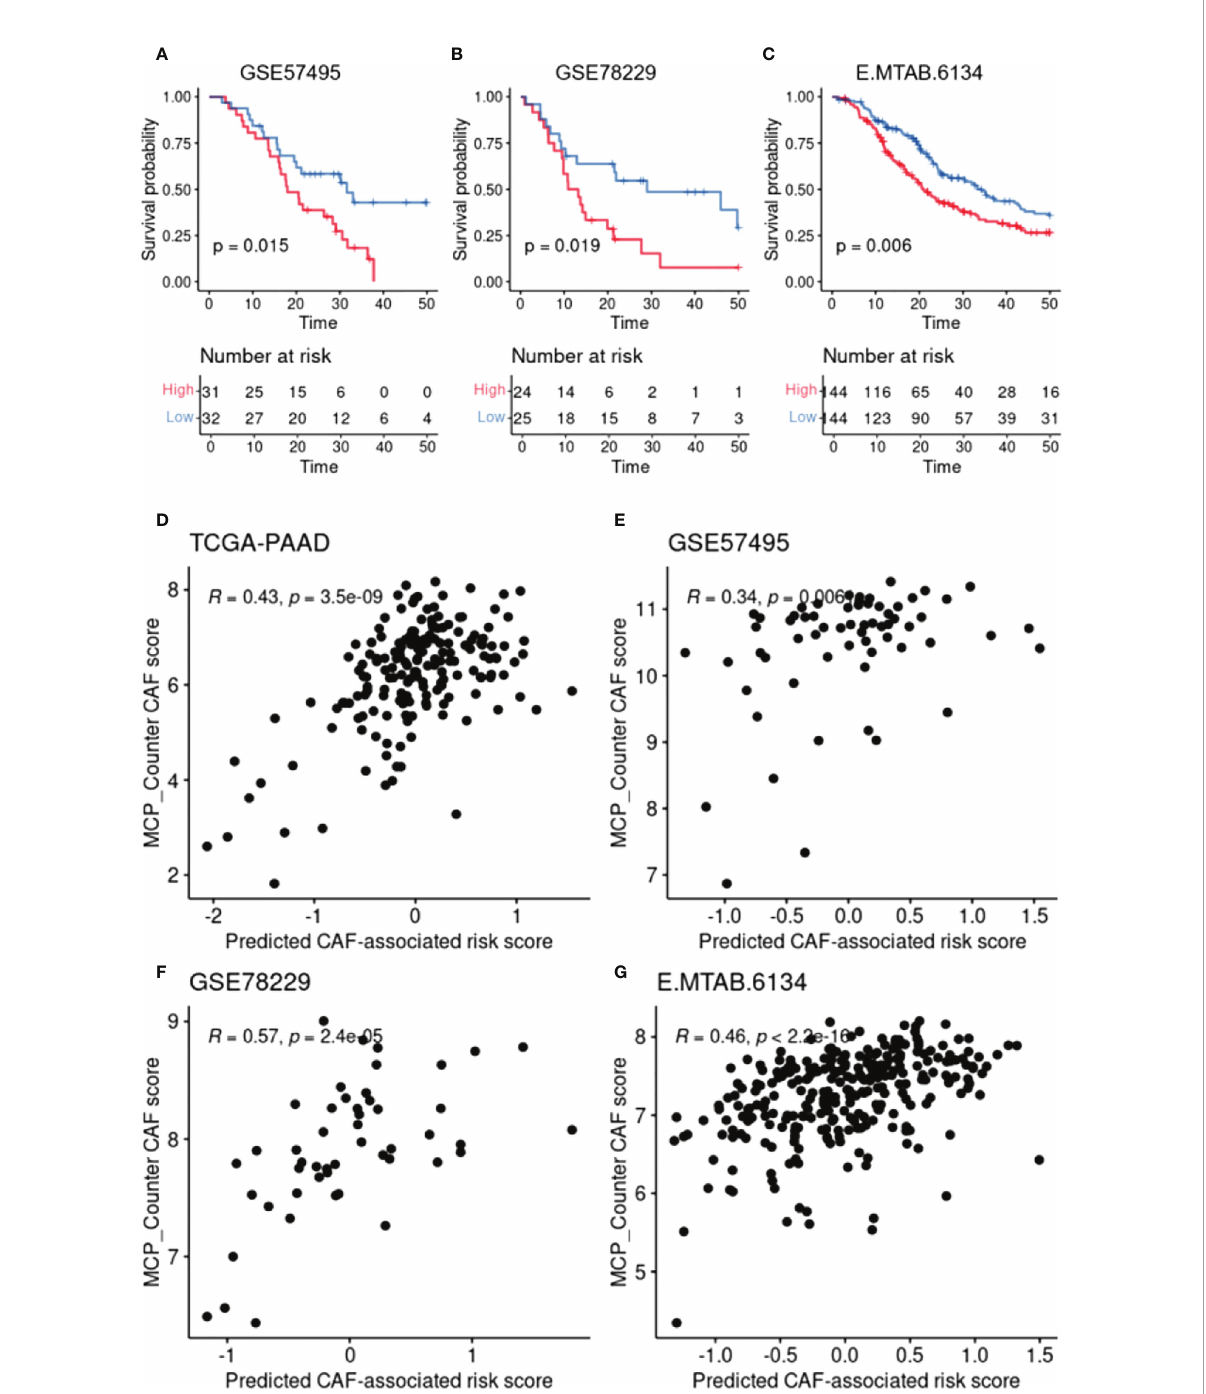
FIGURE 4 CAF-based prognostic model validation and the association with CAF in fi ltration. (A-C) , Kaplan – Meier plots representing the association of the constructed risk model with overall survival in the validation datasets. (D-G) , Scatter plots representing the correlation between the risk model and the calculated CAF in fi ltration using